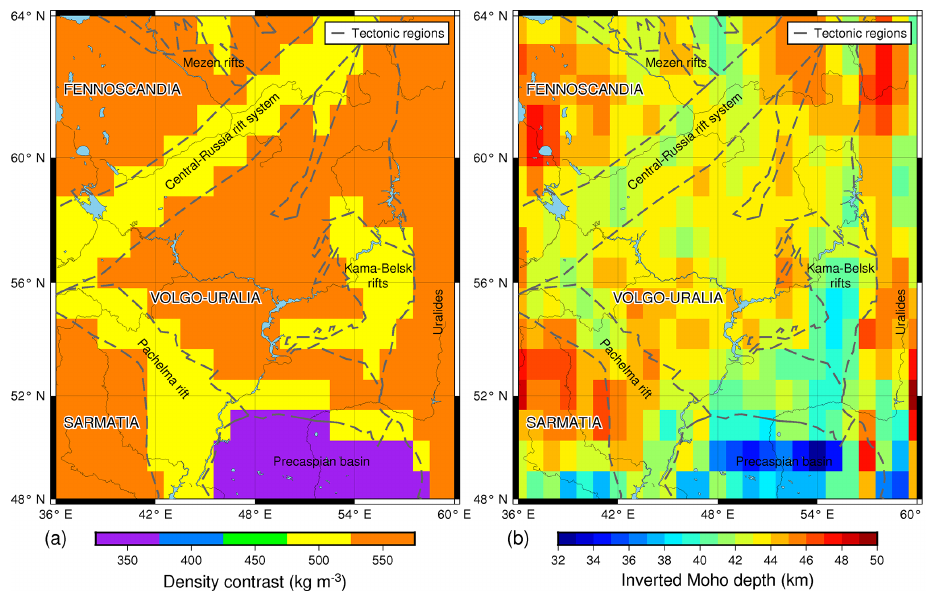
Figure 5. (a) Density contrasts determined by using the algorithm of Haas et al. (2020) and (b) the Moho depth obtained through the gravity field inversion. Reference depth is equal to 45km, crust-mantle density contrast of 550kgm − 3 is assigned to Archaean cratons and Uralide orogen, 500kgm − 3 is assigned to Palaeoproterozoic rifts, and 350kgm − 3 to Precaspian basin.